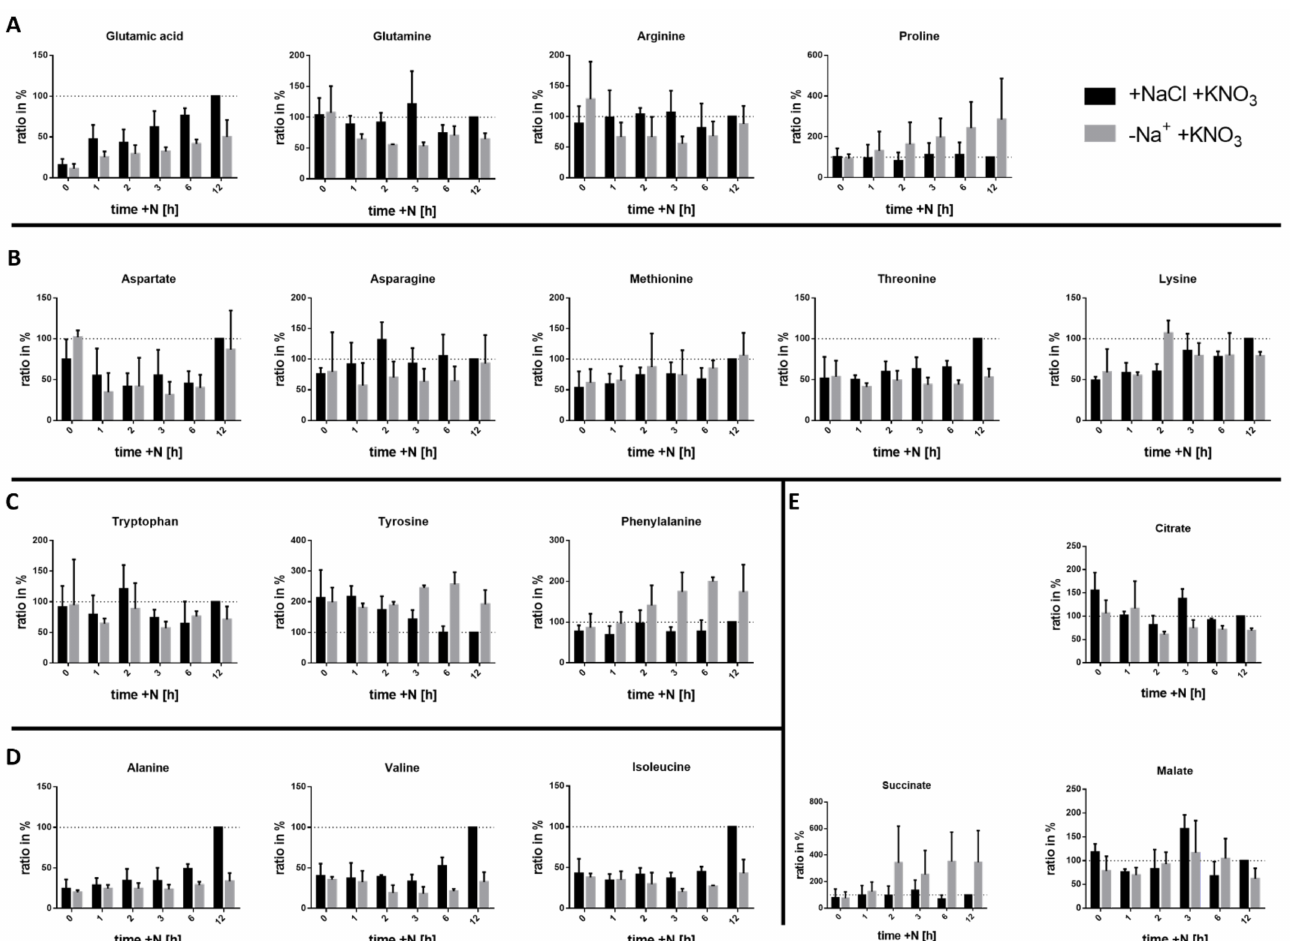
Figure 3. Levels of metabolites during resuscitation in the presence or absence of Na + . Cells were recovered with 17.5 mM KNO 3 after 2 weeks of nitrogen starvation. ( A ) shows the 2-OG amino acid family, ( B ) the oxaloacetate family, ( C ) the aromatic amino acids and ( D ) the pyruvate family. ( E ) shows intermediates of the TCA cycle. The y -axis depicts the ratio in % normalised to 12 h of resuscitation in the presence of sodium, the x -axis shows the time after the addition of nitrate in hours. Bars represent measurement of biological triplicates. Error bars represent the